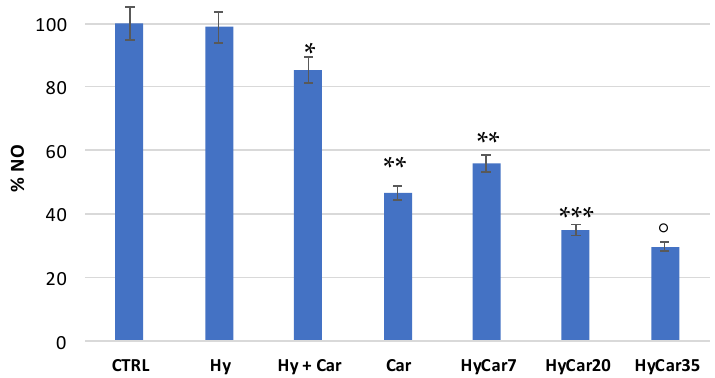
Figure 7. Residual amount of nitric oxide (NO) after the incubation of the NO-donor without (CTRL) or with HyCar and the parent compounds (Hy and Car). (* p < 0.005 vs. Hy; ** p < 0.005 vs. Hy + Car; *** p < 0.005 vs. Car and HyCar7; ° p < 0.01 vs. HyCar20).